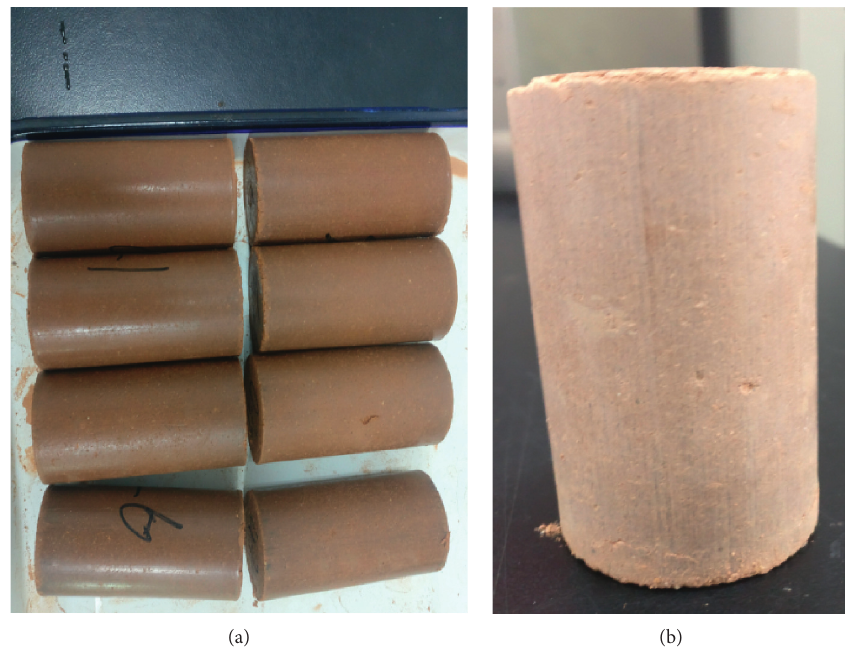
Figure 1: Specimens after the wetting (a) and drying (b).